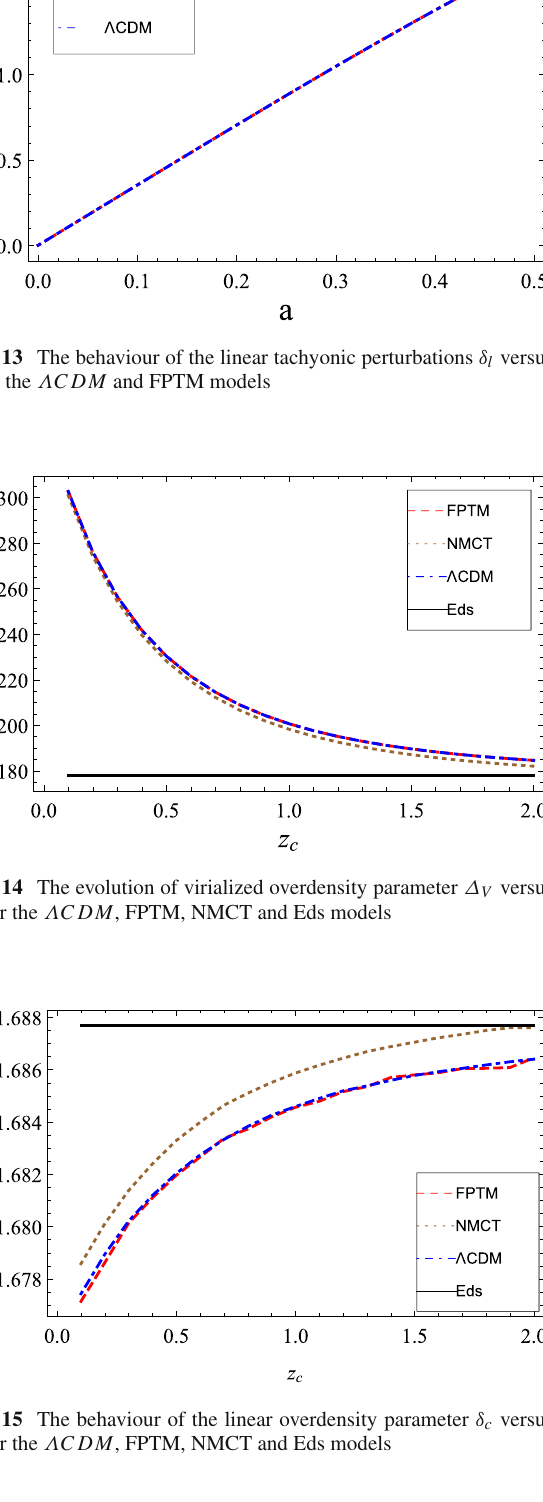
bations are virialized faster, and the structures are formed earlier.